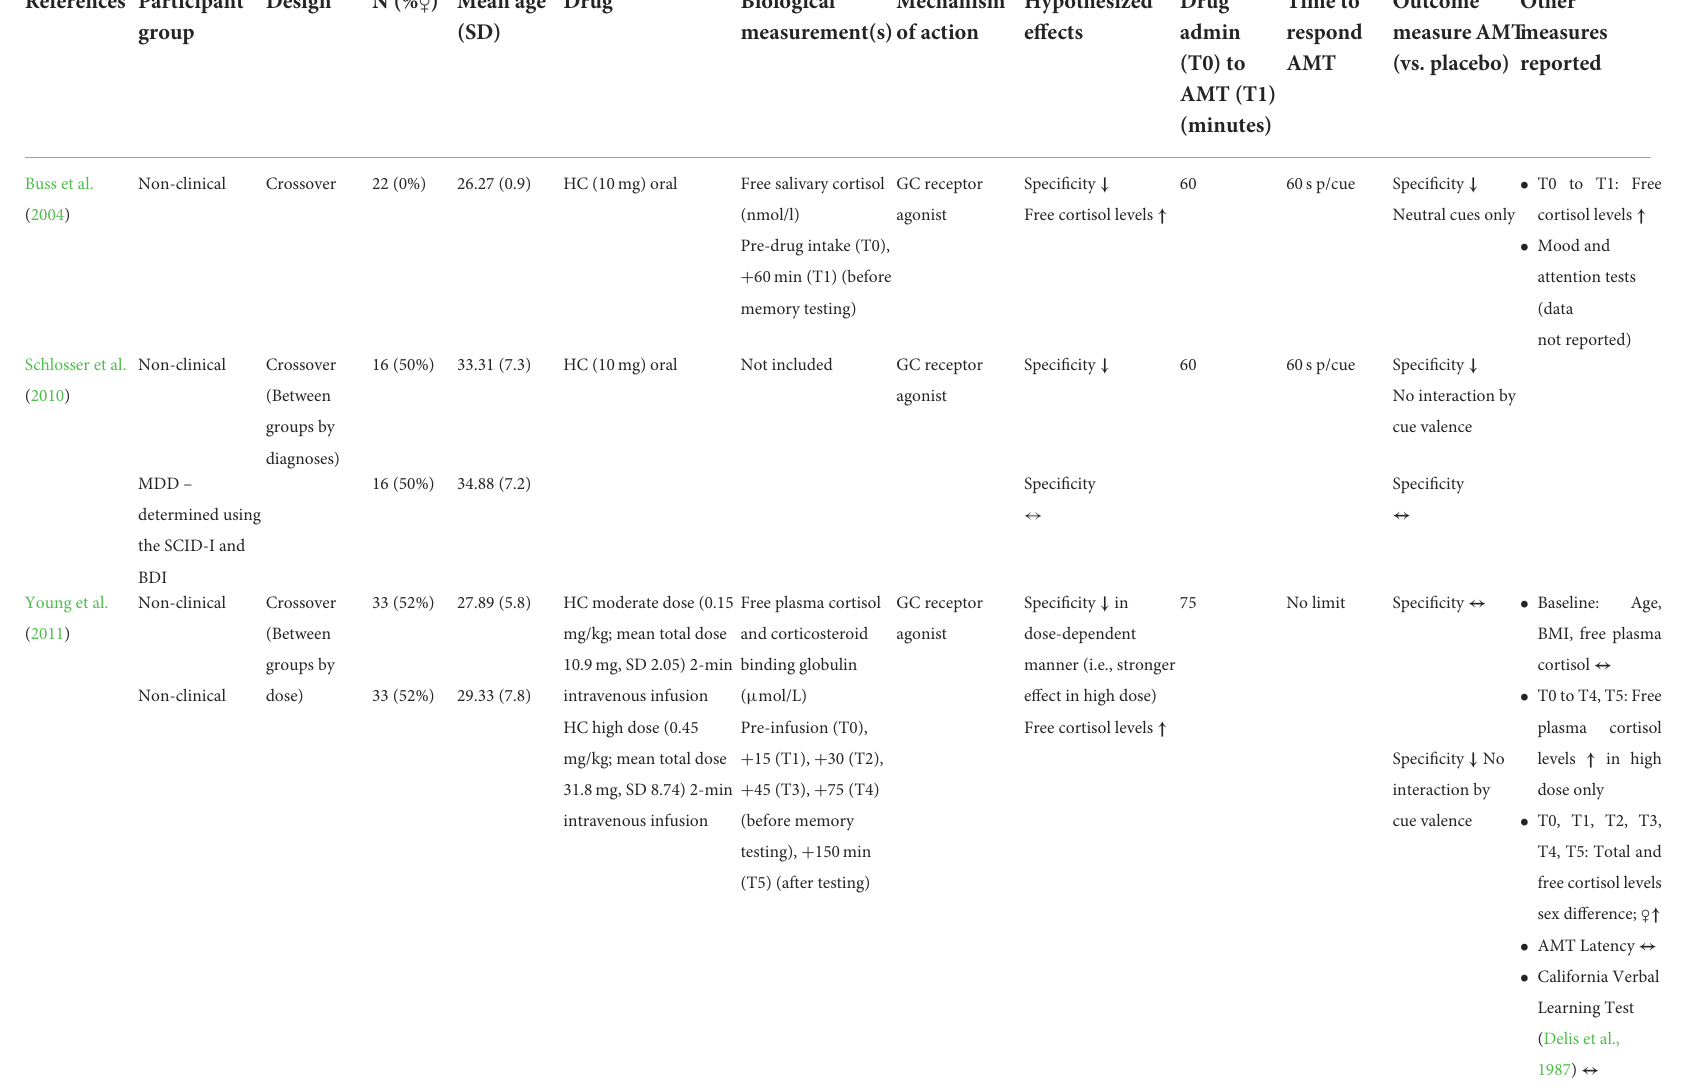
TABLE 1 Characteristics of the 17 reviewed